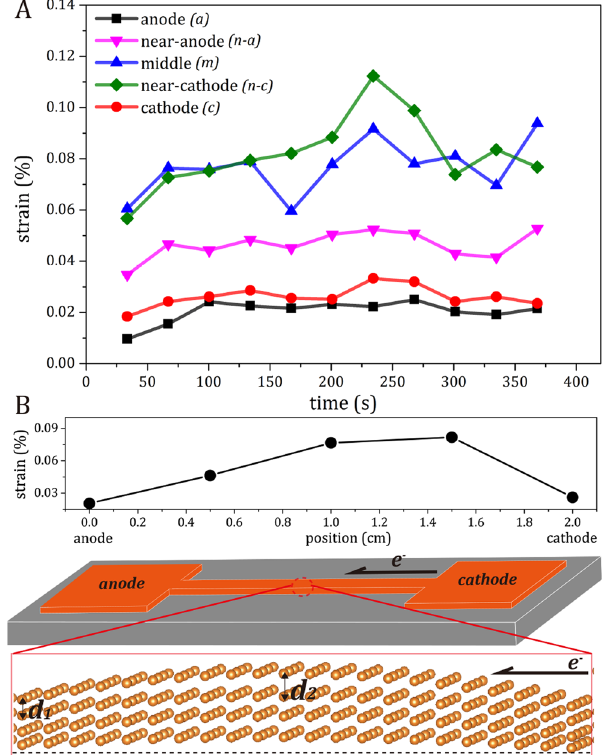
Figure 3. ( A ) The true electron flow-induced strains evolution of the “anode” ( a ), “near anode” ( n-a ), “middle” ( m ), “near cathode” ( n-c ), and “cathode” ( c ) of Cu strip under stressing at the current density of 4 × 10 5 A/cm 2 ( B ) The extents of electron flow-induced strains along the Cu strip, and the schematic diagram illustrating the constrained electron flow-induced lattice expansion of the dog-bone-shape Cu